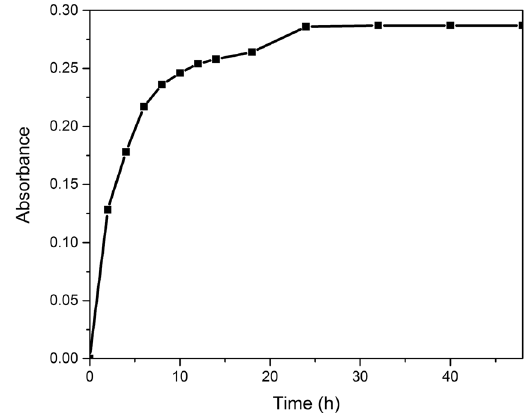
Figure 15: Drug release curve of BSA/AM microcapsules.